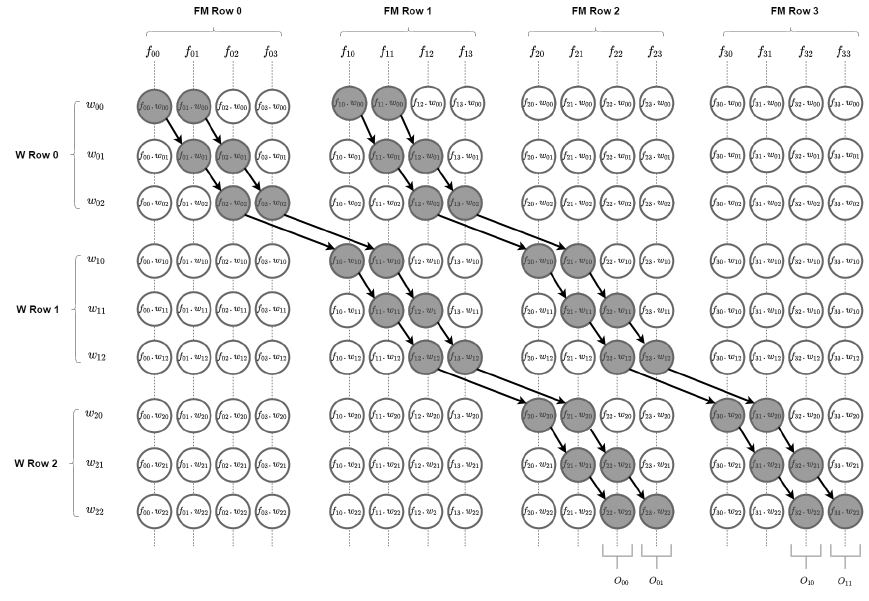
Figure 3. Dependency dataflow for a 4 × 4 FM, a 3 × 3 filter with stride = 1 and padding = 0.